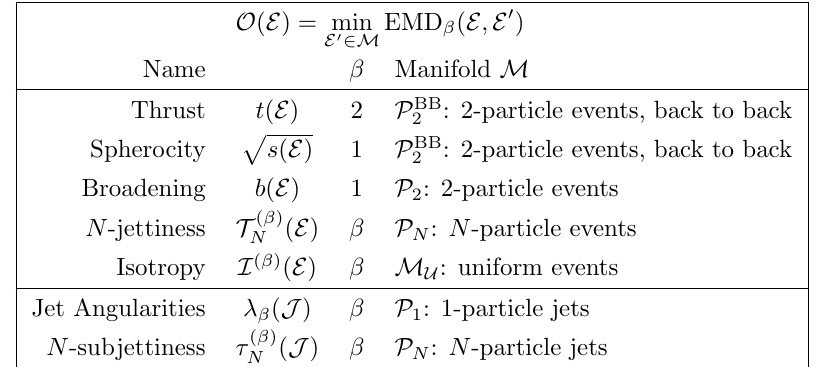
Figure 4 . An illustration of an observable the EMD, between the event into this precise form, stated in eq. (1.7), with particular choices of manifold.